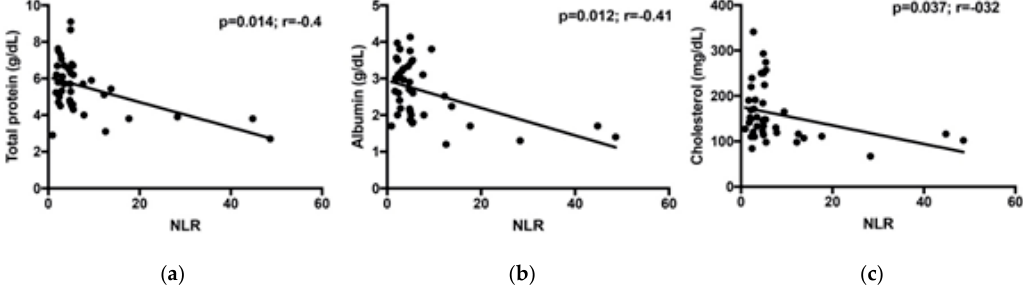
Figure 3. Correlation between NLR and total protein ( a ), albumin ( b ), and cholesterol ( c ) of IBD dogs.